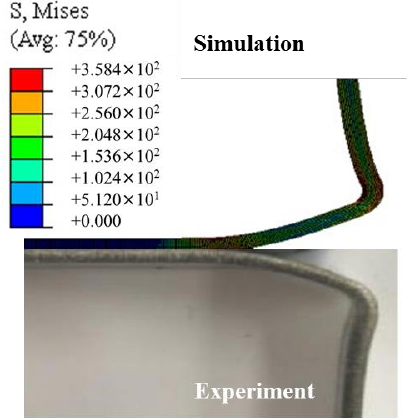
Figure 11. Comparison of the crack propagation results: simulation vs experiment.